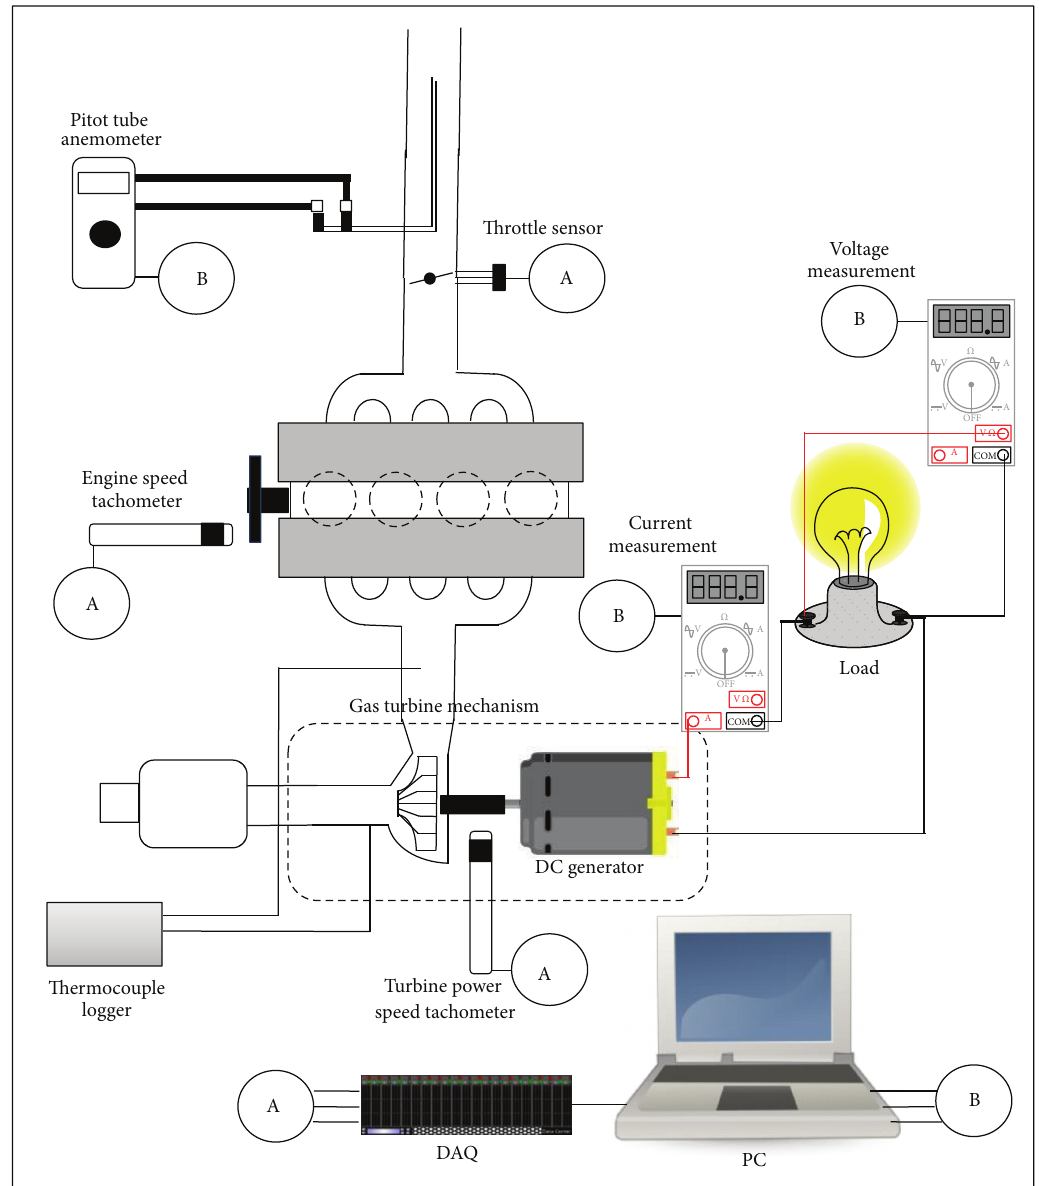
Figure 1: Schematic layout of the experimental setup of waste heat recovery